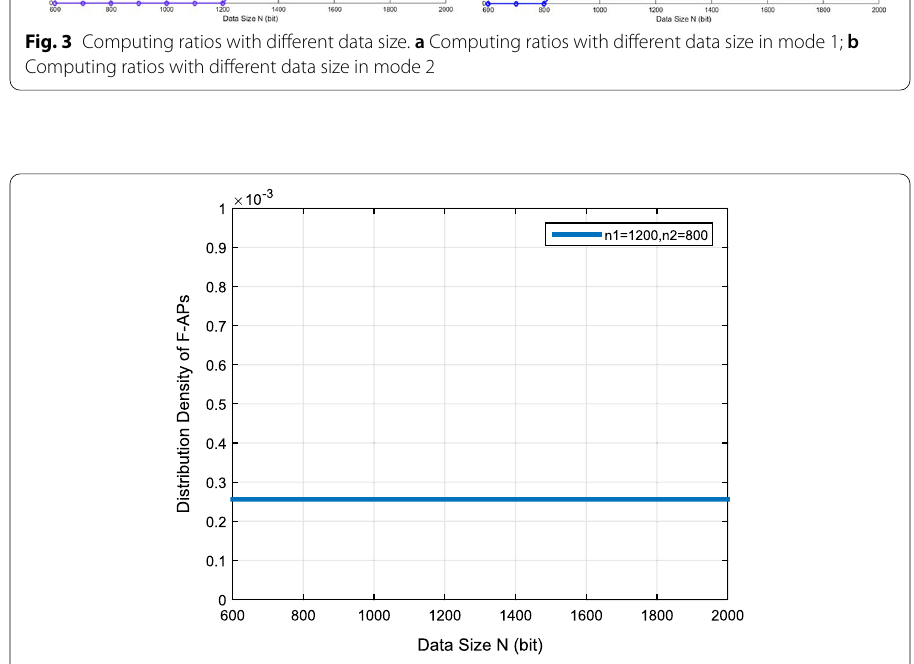
Fig. 4 Distribution density with different value of data size